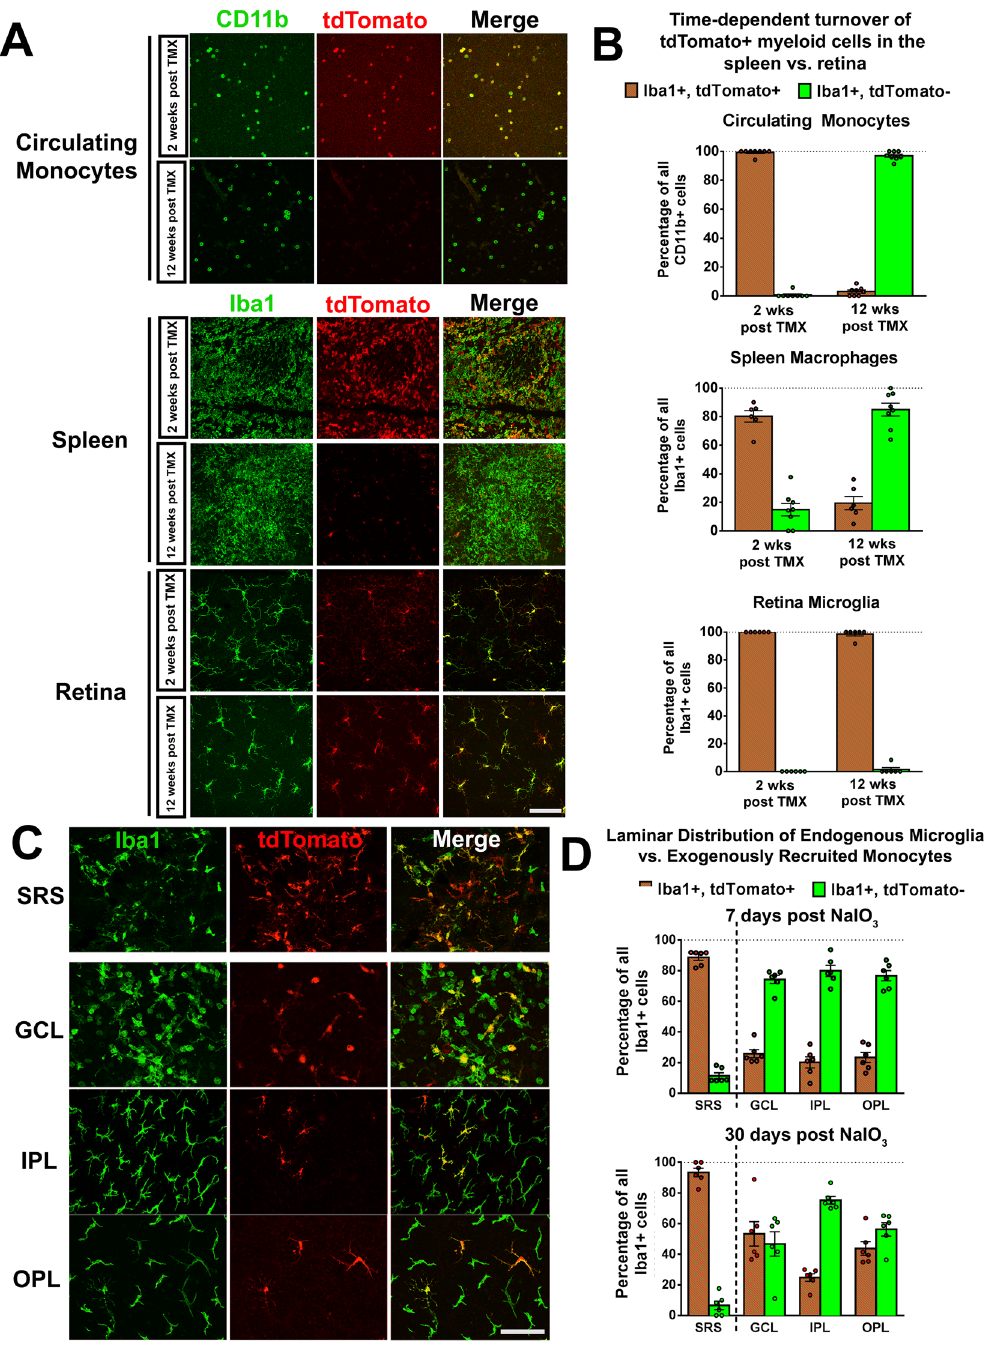
Figure 2. NaIO3-induced RPE injury induced early mobilization of endogenous retinal microglia from the inner retina to the subretinal space and the subsequent repopulation of the inner retina by infiltrating monocytes. ( A ) Use of the Cre-tdT transgenic mouse model enabled specific labeling of endogenous microglia in the retina, but not monocytes in the systemic circulation (i.e. “fate mapping” of microglia vs. monocytes). Young 2-month old CX3CR1 CreER/ + :Rosa26-flox-STOP-flox-tdTomato (Cre-tdT) transgenic mice were administered tamoxifen (TMX) by oral gavage (two doses 1 day apart, 500 mg/kg per dose) to induce the expression of tdTomato ( red ) specifically in CX3CR1-expressing myeloid cells, which were also marked by Iba1 or CD11b immunolabeling ( green ). At 2 weeks following tamoxifen induction, CD11b + circulating monocytes ( top row) isolated from the blood using flow cytometry cell sorting, uniformly co-expressed tdTomato. At 12 weeks following induction, following the time-dependent turnover of circulating monocytes, almost all CD11b + cells were tdTomato-negative. The majority of Iba1 + myeloid cells in the spleen ( middle ) underwent a similar turnover between 2 and 12 weeks post-tamoxifen induction. By contrast, all Iba1 + microglia in the retina were tdTomato + at both 2 weeks and 12 weeks after tamoxifen induction. ( B ) Quantification of the proportion of tdTomato + among myeloid cells at 2 and 12 weeks in the blood, spleen, and retina. ( C ) At